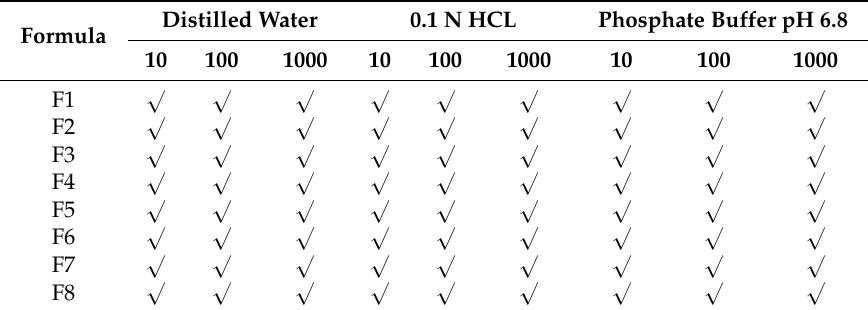
Table 5. Robustness to Dilution Results of Various OLM Loaded SNEDDS